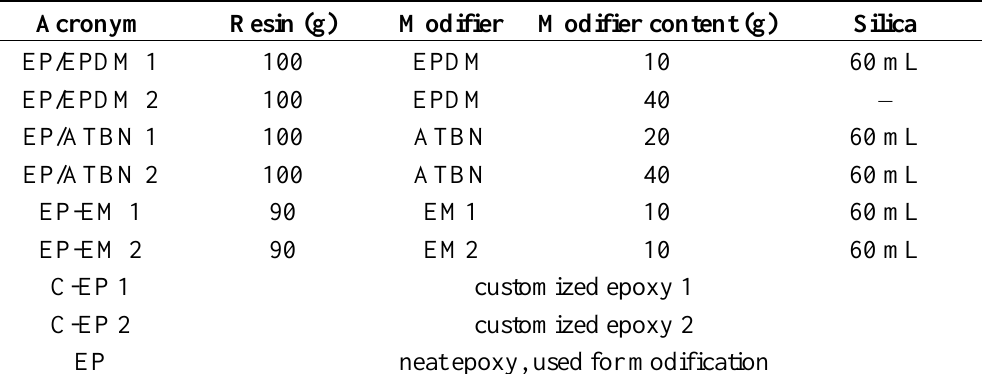
Table 1. Acronyms for the epoxies and their